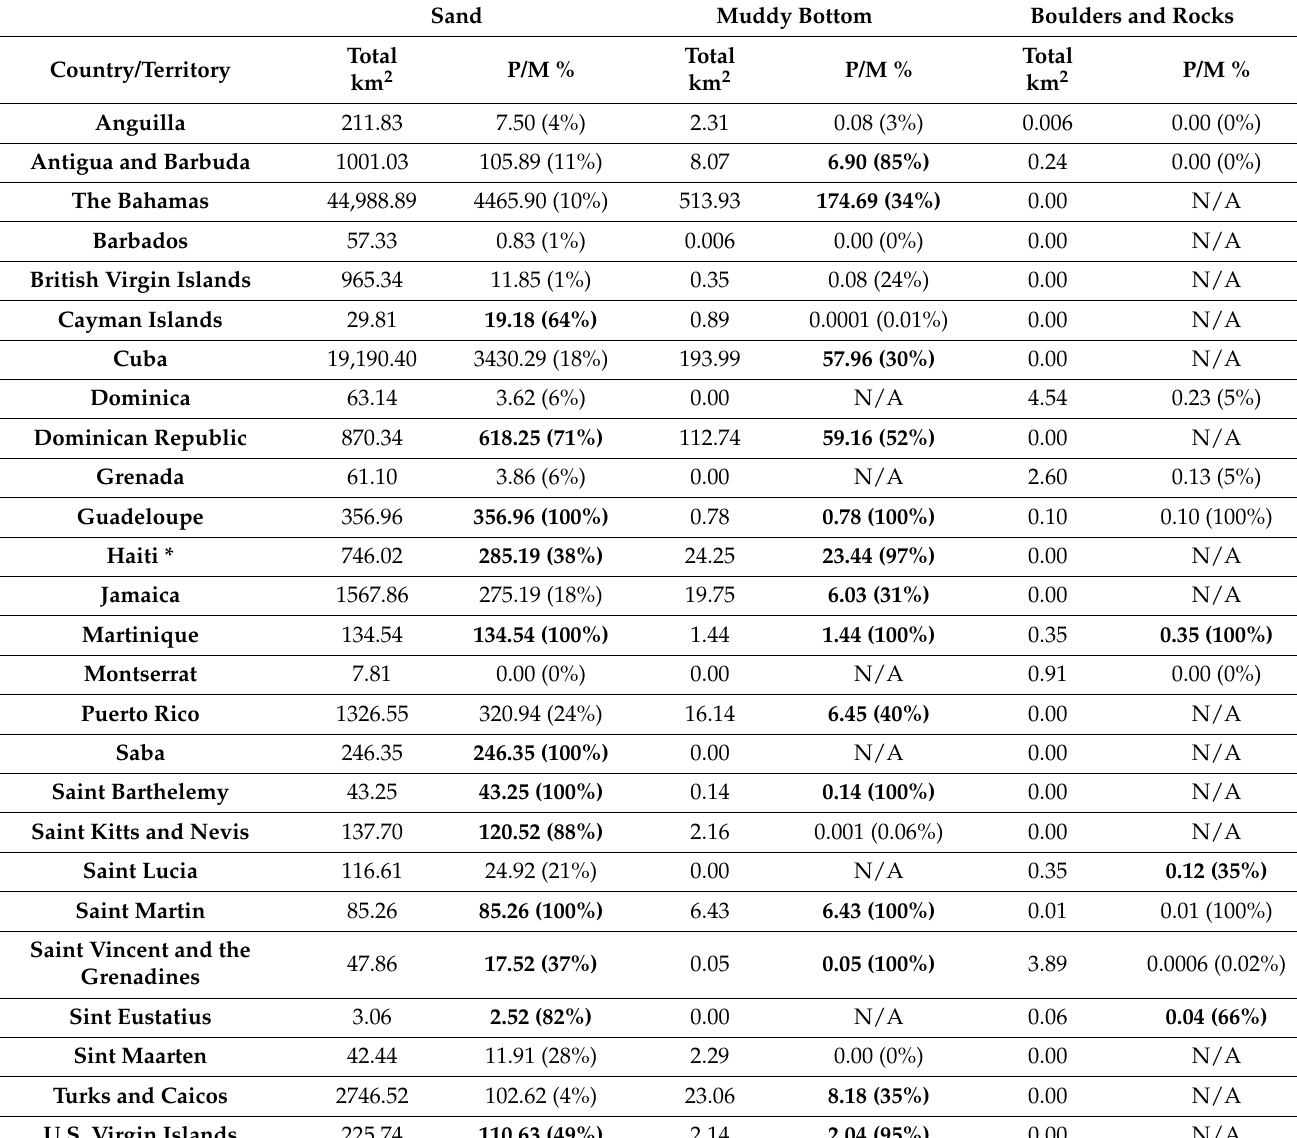
Table 8. Total area (km 2 ) of other benthic habitat classes within the shallow marine zone (<30 m depth) of the Insular Caribbean per EEZ and corresponding area and percentage within declared marine protected or managed areas. The total protection percentages in bold indicate attainment of at least 30% of the area of the